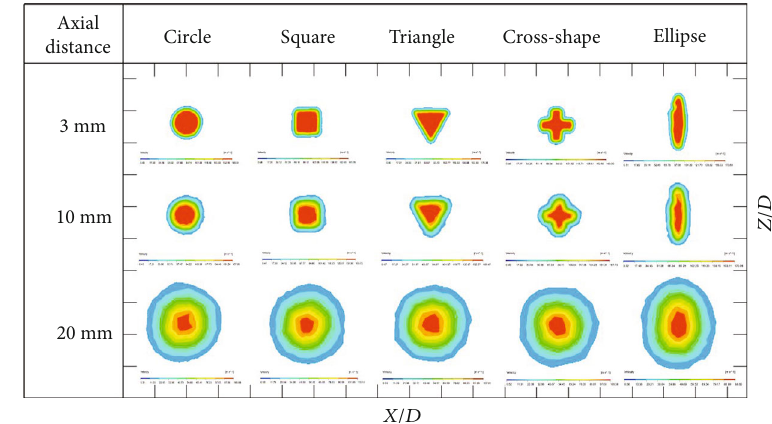
Figure 5: The velocity contour of the water jet at di ff erent